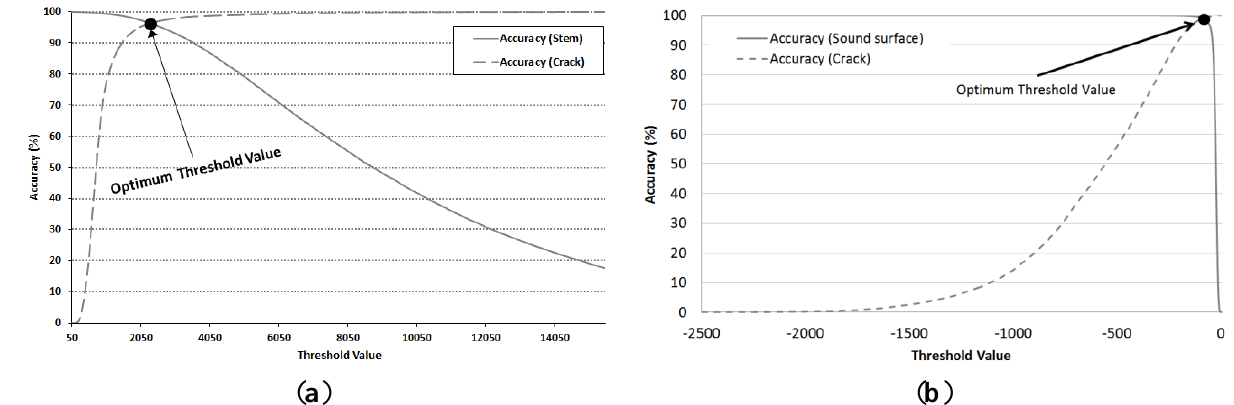
Figure 9. Classification aaccuracy when threshold value of two groups is applied: ( a ) stem vs. crack; ( b ) sound area vs.